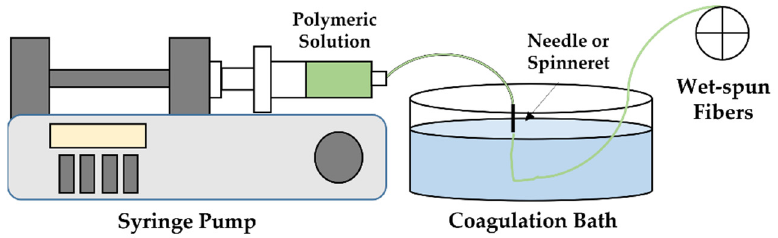
Figure 6. Schematic representation of the wet-spinning apparatus.